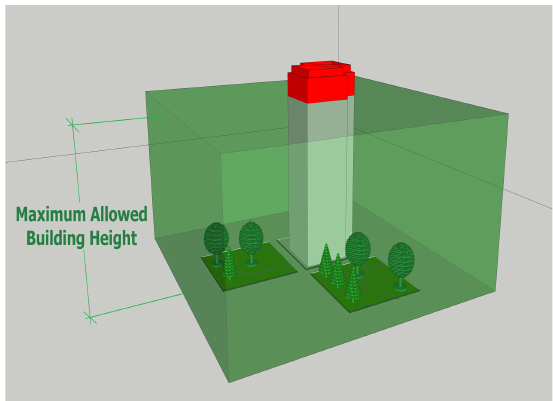
Figure 3. Building height regulation conflict (in RED